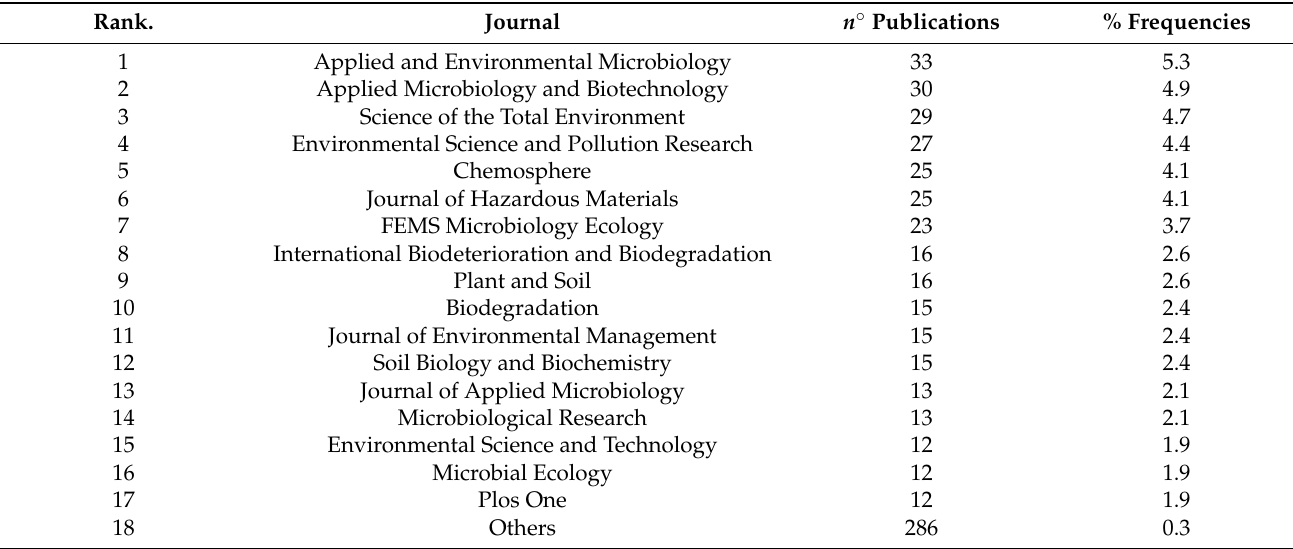
Table 1. The most productive journals in soil microbial inoculants application research.